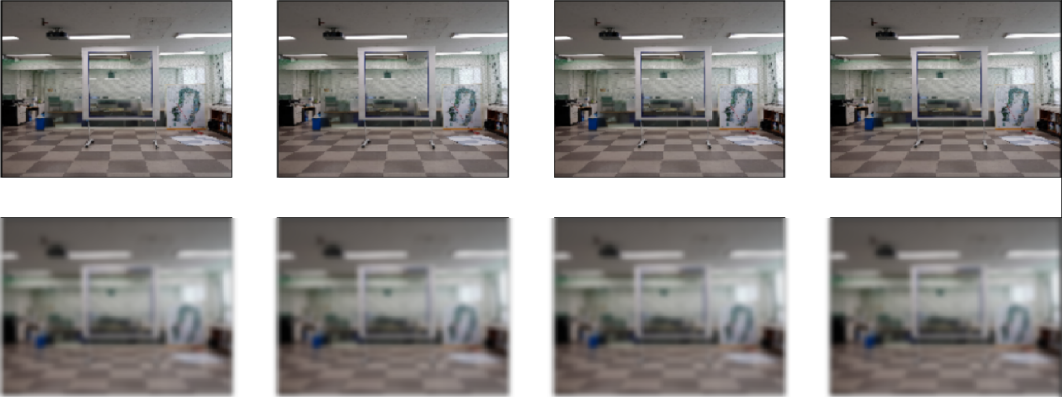
Figure 3. Original ( top ) and blurred ( bottom ) sample images.